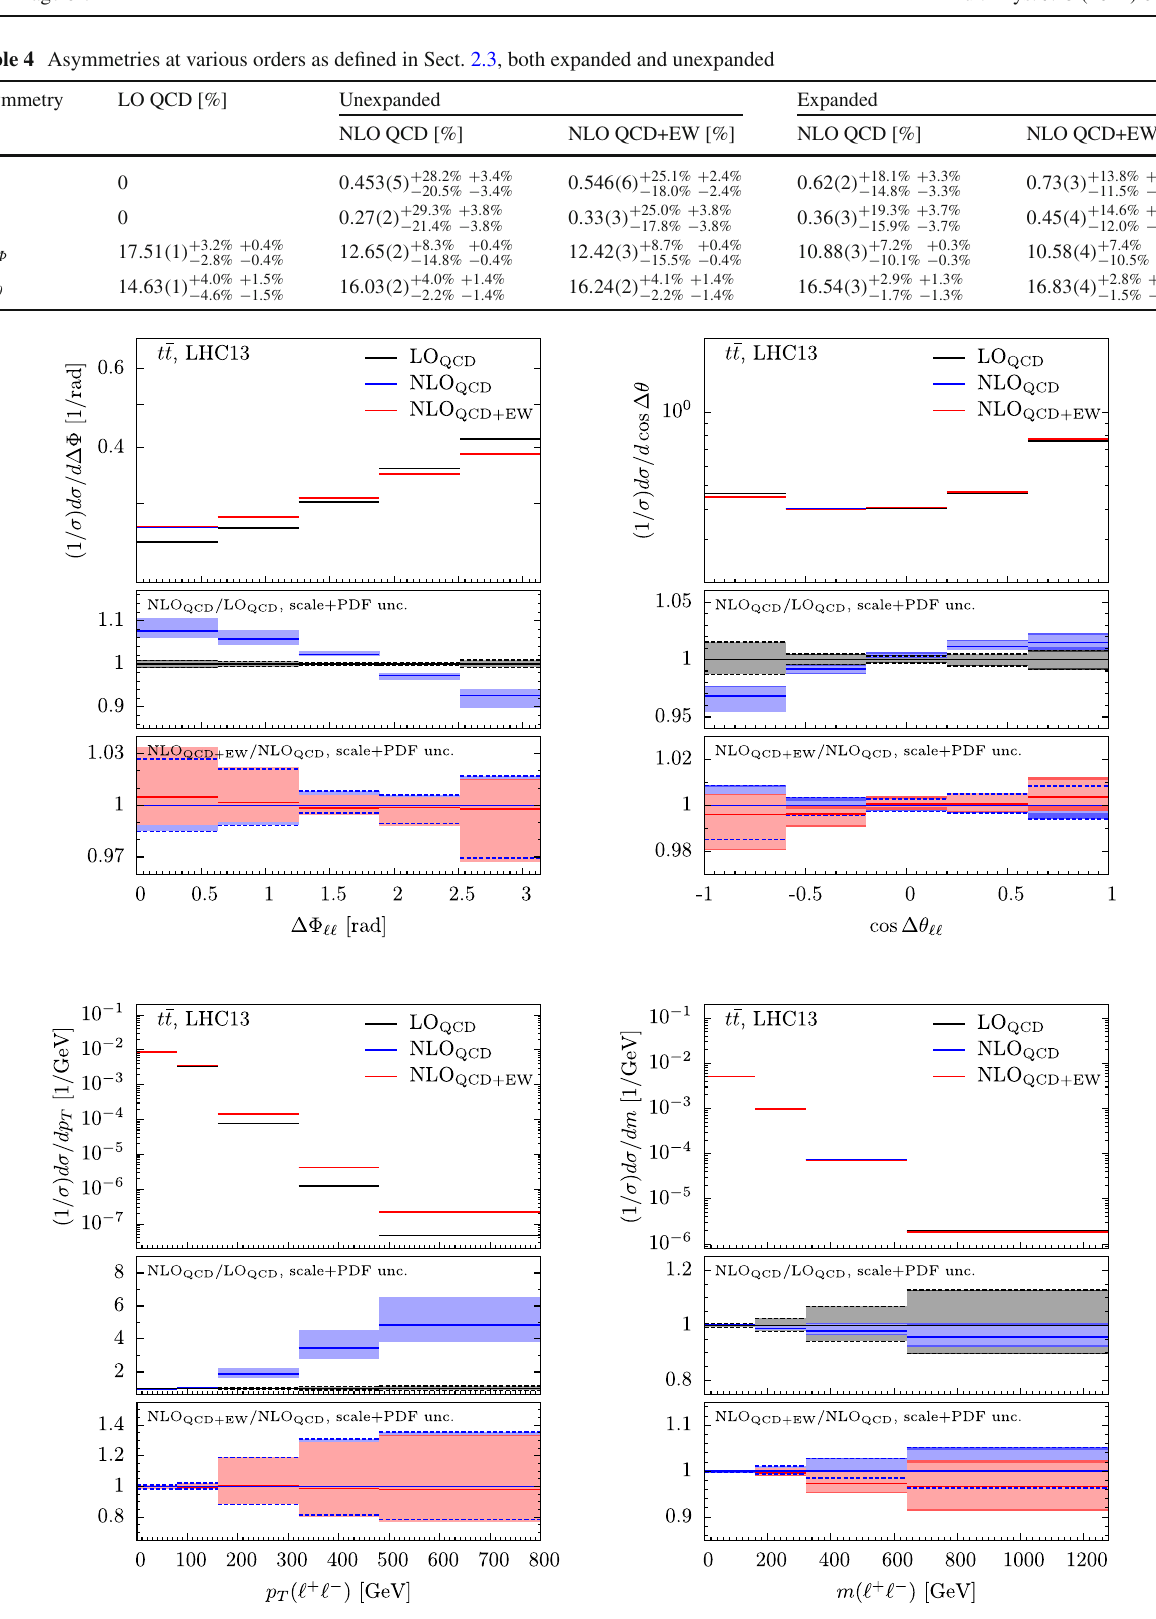
Fig. 2 The ΔΦ (cid:4)(cid:4) distribution (upper left) and cos Δθ (cid:4)(cid:4) distributions (upper right), transverse momentum of (cid:4) + (cid:4) − system (lower left) and dilepton invariant mass distribution (lower